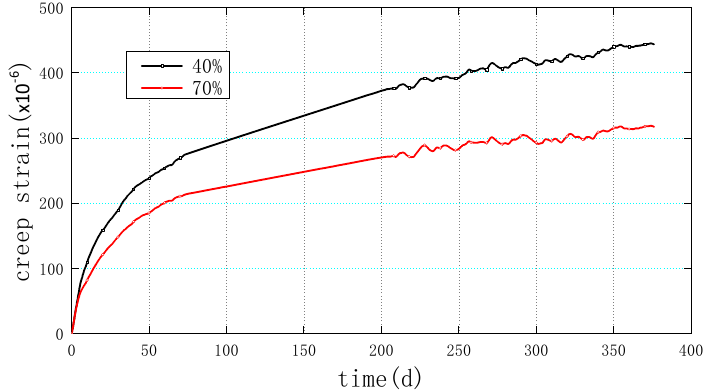
Figure 12. Evolution of reinforcement strain in the compression zone of the RC T ‐ beam for two loading levels (loading age of 14 days).